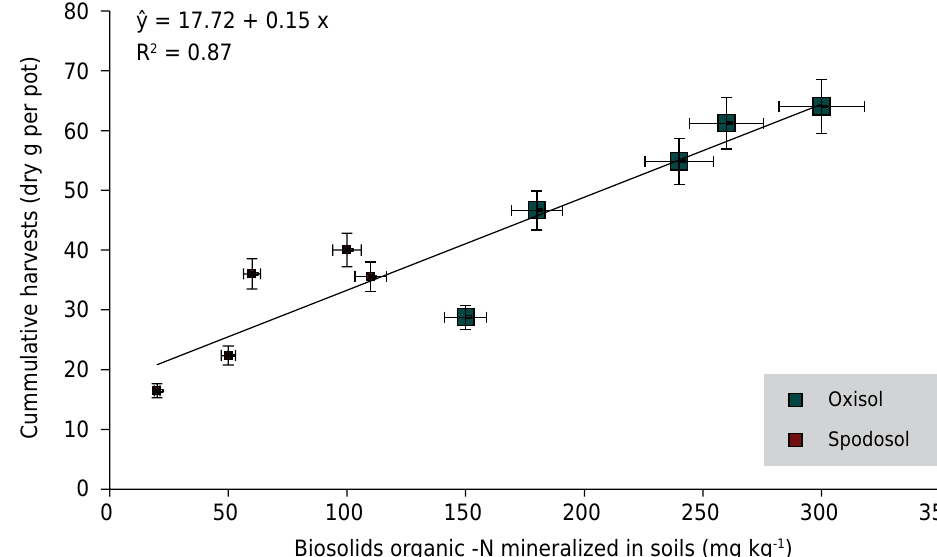
Biosolids organic -N mineralized in soils (mg kg -1 ) Figure 3. Ryegrass cumulative harvests as a function of biosolids-N mineralized in soils in 11 months of a plant trial.